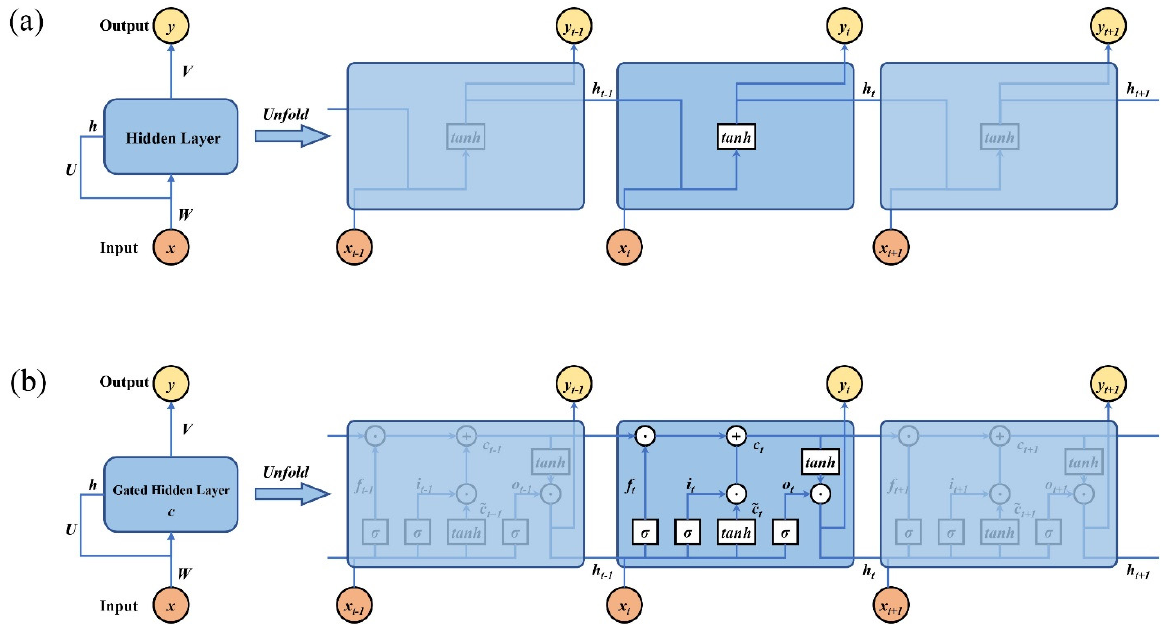
Figure 1. The typical structure of ( a ) traditional RNN and ( b ) LSTM.